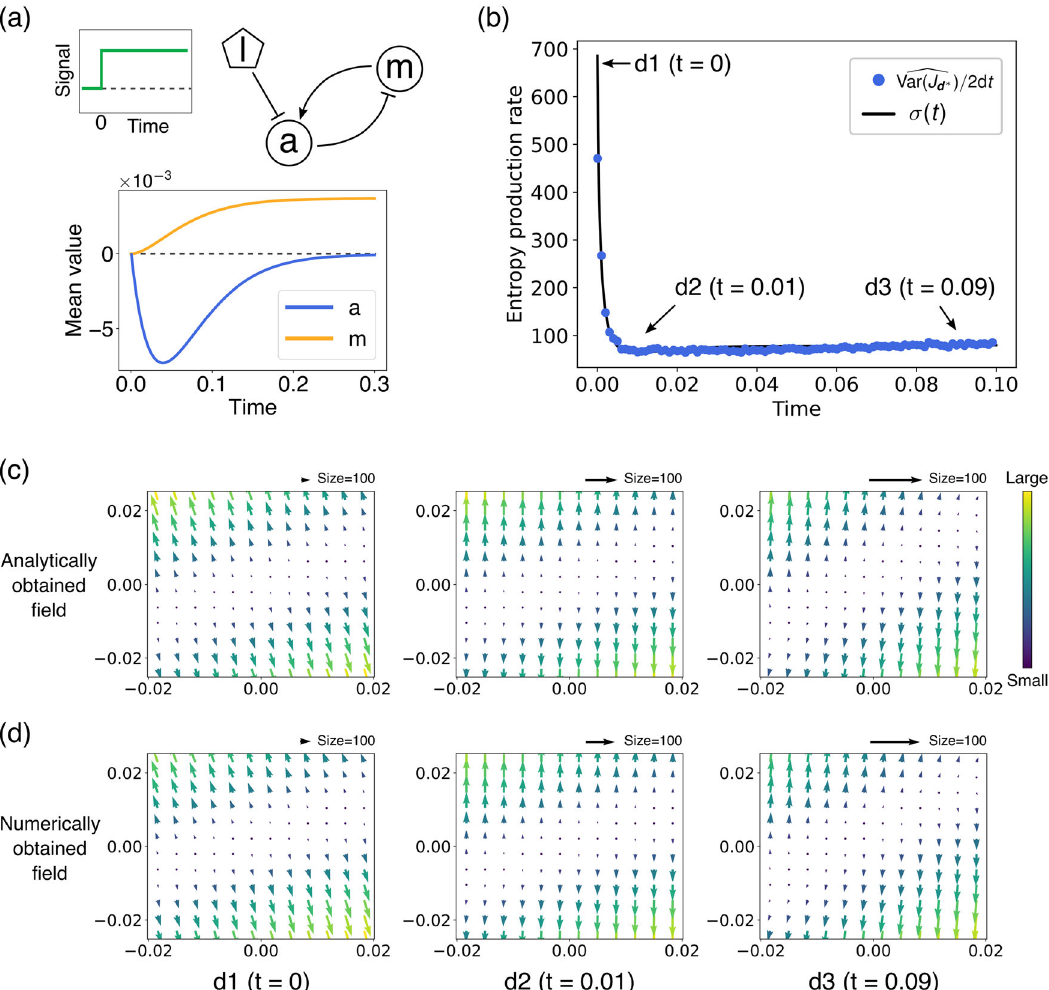
Fig. 2 Estimation in the adaptation model. a Sketch of the model. The line with an arrow represents activation, and the line with a fl at end represents inhibition. The average dynamics of the output activity a and the feedback controller m after the switching of the inhibitory input l are plotted. b Estimated entropy production rate. The blue circles are the estimated values of a single trial (using 10 4 trajectories) using the variance-based estimator (Eq. (14)). The black line is the true entropy production rate. The labels d1, d2, and d3 are the time instances when we also estimate the thermodynamic force as shown in ( c ). c Analytical solutions for the thermodynamic force at the instances d1, d2, d3, and (d) estimates over 10 4 trajectories. Here the horizontal axis is the direction of a , the vertical axis is that of m , and an arrow representing the size of 100 is shown at the top of each fi gure for reference. The brighter the color, the larger the thermodynamic force as shown in the color bar. Note that in this particular case, the thermodynamic force becomes weaker as time evolves, and hence the size of the vectors reduces. The system parameters are set as follows: the time constants τ a = 0.02, τ m = 0.2, the coef fi cients of the mean activity function α = 2.7, β = 1, the strengths of the white noise Δ a = 0.005( t < 0), 0.5( t ≥ 0), Δ m = 0.005, and the inhibitory input l ( t ) = 0( t < 0), 0.01( t ≥ 0), which are taken from realistic parameters of E. coli chemotaxis 65,66 . The trajectories of length τ = 0.1 are generated with the obs time interval Δ t = 10 − 4 . The simple dual representation (Eq. (10)) is used for training the model